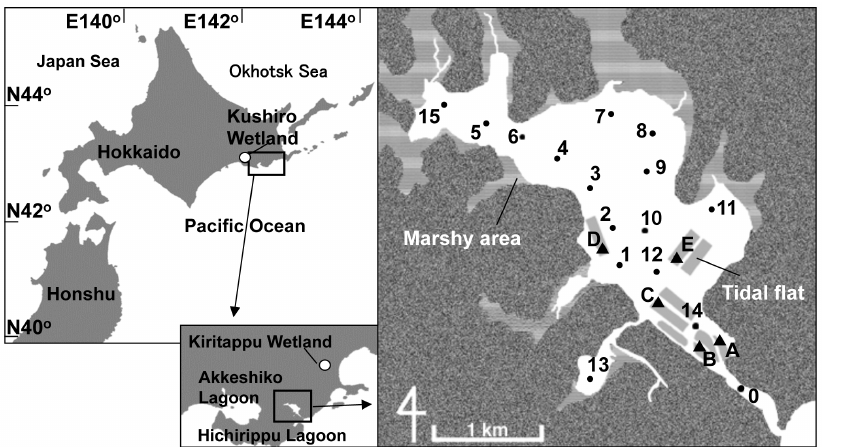
Figure 1. Study area and locations of sampling stations. The oval and rectangular grey areas represent naturally occurring (stations A and B) and artificial tidal flats (the other stations), respectively.